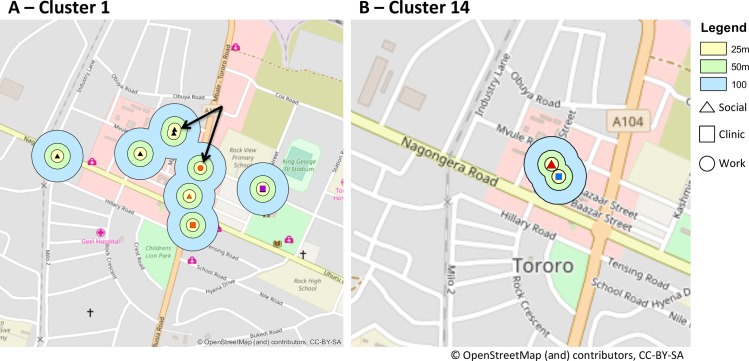
Maps of potential sites of TB transmission within MTB Genotype Clusters 1 and 14, based on geographically adjacent locations of work, healthcare, household or social locations–with each location point color corresponding to a TB patient.Yellow, green and blue circles show buffer zones of 25 meters (m), 50m and 100m respectively, around each mapped location. The arrows in Panel A show that within MTB Genotype Cluster 1, one work location named by a TB patient (red circle) was <100m from two social venues (black triangles) named by another patient. Panel B shows that within Genotype Cluster 14, one TB patient’s clinical location was adjacent (<50m) to a social location visited by another TB patient.